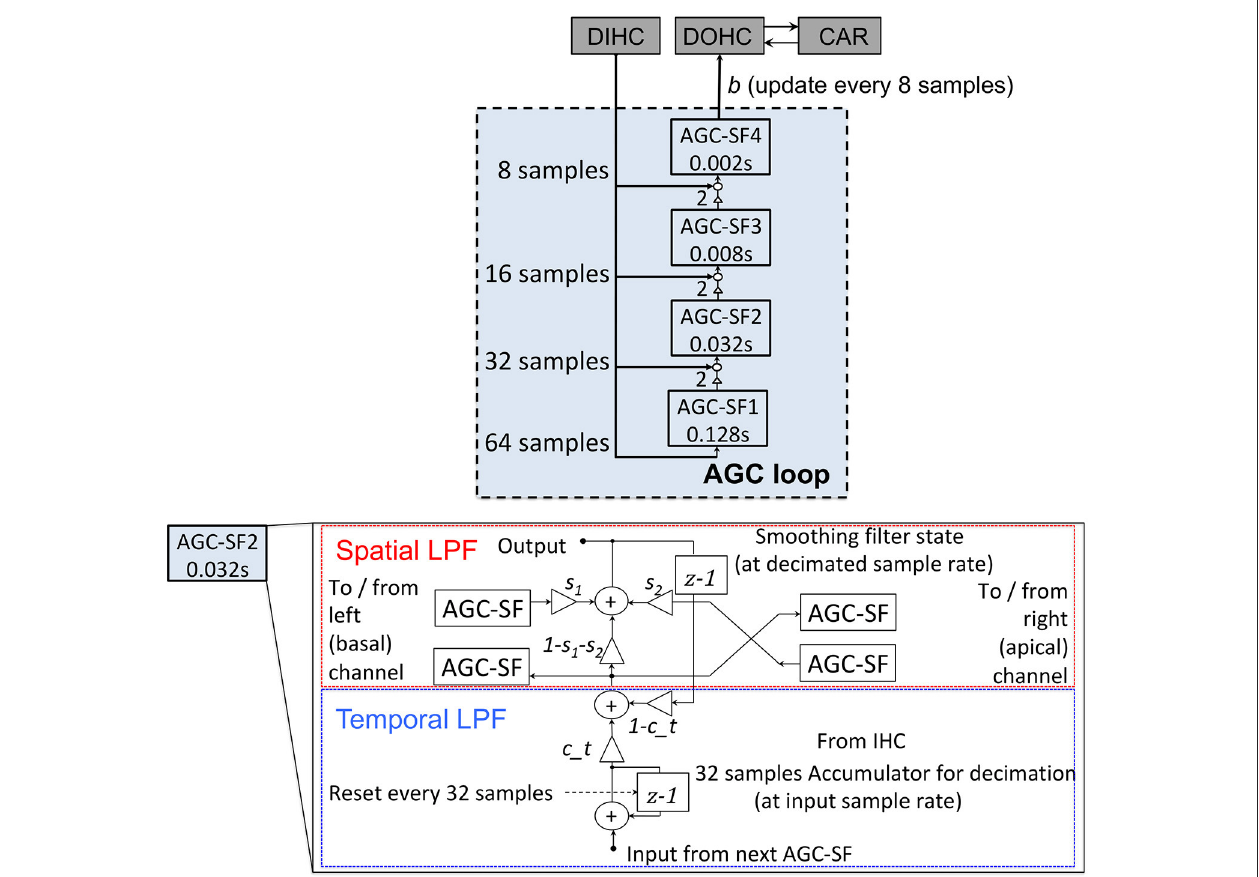
FIGURE 6 | Structure of the AGC loop. Four stages of the temporal smoothing filters (SF) (Upper). Each stage consists of a temporal LPF with a defined time constant (0.002, 0.008, 0.032, and 0.128s) and a three-tap spatial smoothing filter. The internal structure of an AGC-SF (Lower), the input of the AGC-SF comes from the lower filter stage with the smaller time constant as well as the accumulation of the DIHC. The output goes to the next stage of the temporal filter. The spatial smoothing filter is a three-tap smoothing filter coupled with lateral channels. s 1 , s 2 , and 1 - s 1 - s 2 are the spatial filter coefficients. c_t is the temporal LPF coefficient calculated from the time